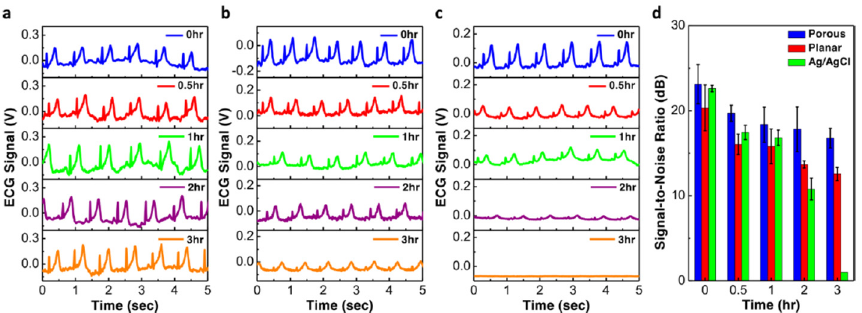
Figure 6. Long-term ECG signal recording. ( a – c ) ECG signals measured after various amount of time using ( a ) porous PEDOT:PSS/PDMS electrodes; ( b ) planar PEDOT:PSS electrodes; and ( c ) commercial Ag/AgCl electrodes. ( d ) Comparison of the signal-noise ratio between the three different types of electrodes. Maintaining a high signal-to-noise ratio over longer time periods with novel electrode technologies may help to decrease the need for frequent electrode replacements when using ECG-based wearable devices. Reprinted from [36]. No changes were made to the image, which has been published under CC BY 4.0 license (https://creativecommons.org/licenses/by/4.0/legalcode).